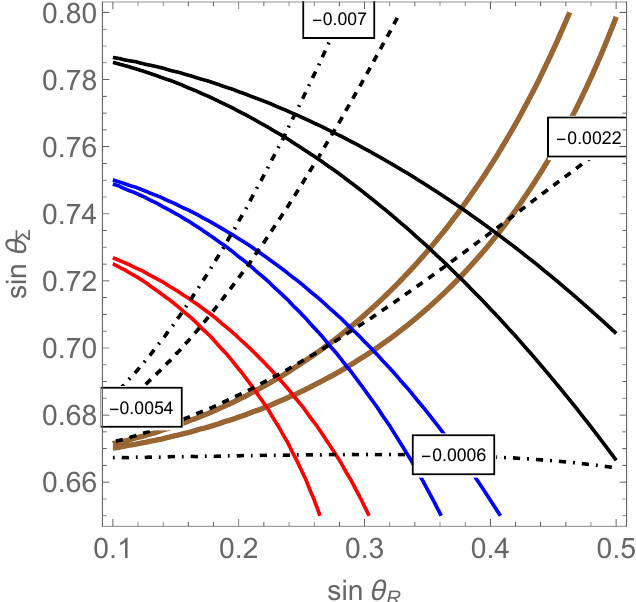
Figure 9 . The region between the solid lines is allowed by (cid:14)g Z m 1 = 3 TeV and tan (cid:12) = 1 (black lines) tan (cid:12) = 3 (blue lines) and tan (cid:12) = 5 (red lines). Region between dashed (dot-dashed) lines encompasses the 1 (cid:27) (2 (cid:27) ) interval for the anomaly in A b